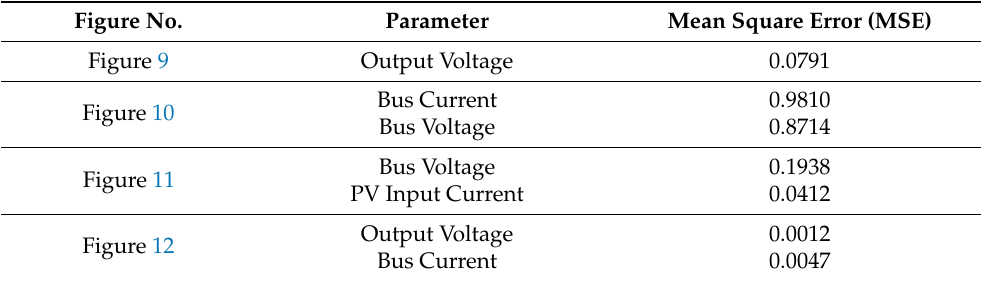
Table 2. Simulation parameters of dc nanogrid-based DES. Figure No.